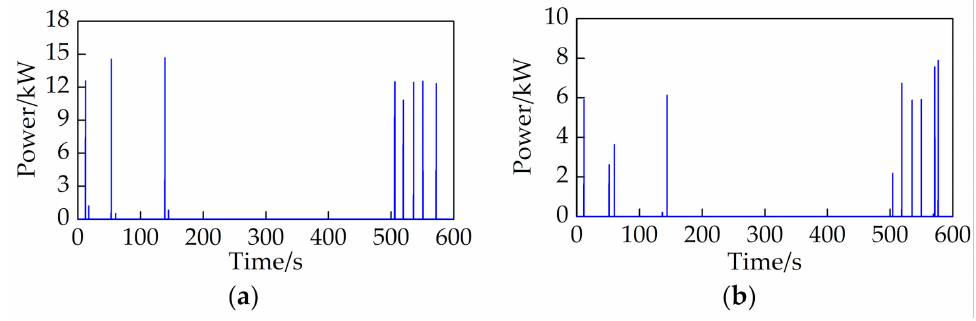
Figure 16. Driving power drop results under US06 cycle: ( a ) LTB strategy; ( b ) AVPRB strategy.